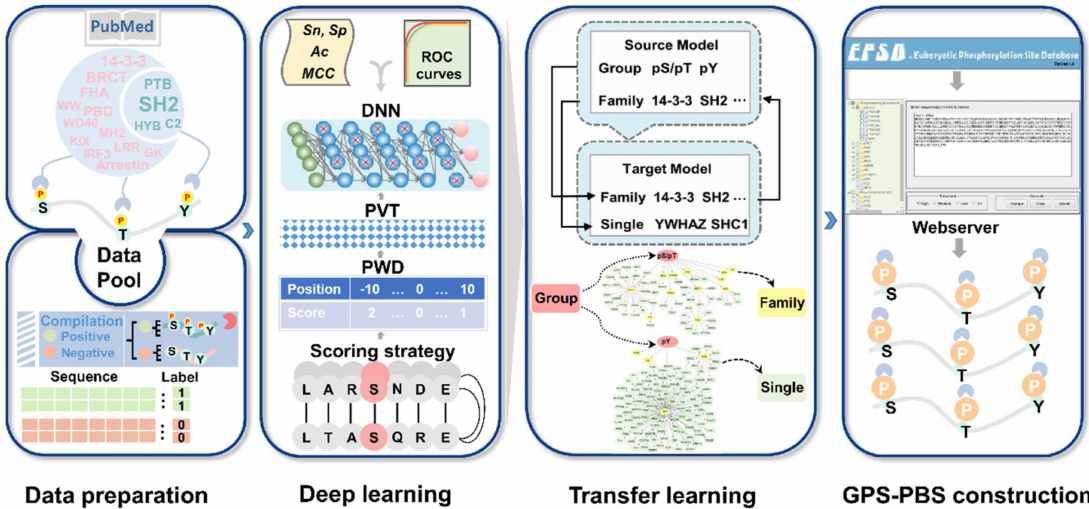
Figure 1. The full experimental procedure of the study. From the scientific literature and the PepCyber:P~PEP database [17], we collected 4458 known PBSs in 950 PPBPs that interact